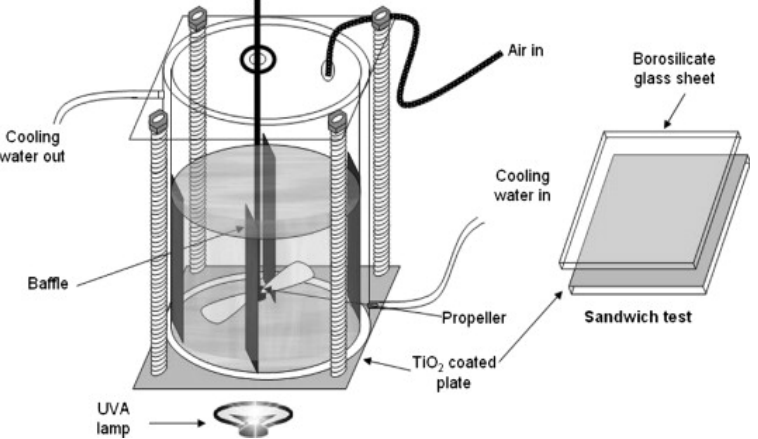
Figure 11. Stirred tank reactor for E. coli inactivation. Reprinted from [133], Copyright (2020), with permission from Elsevier.